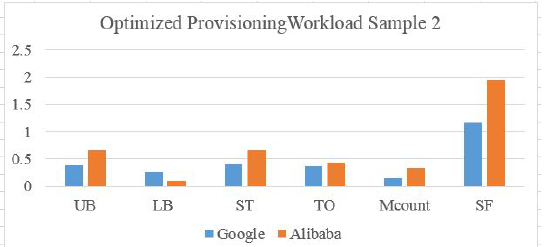
Figure 19. Optimized Scaling Ratios for Google and Alibaba Workload Type